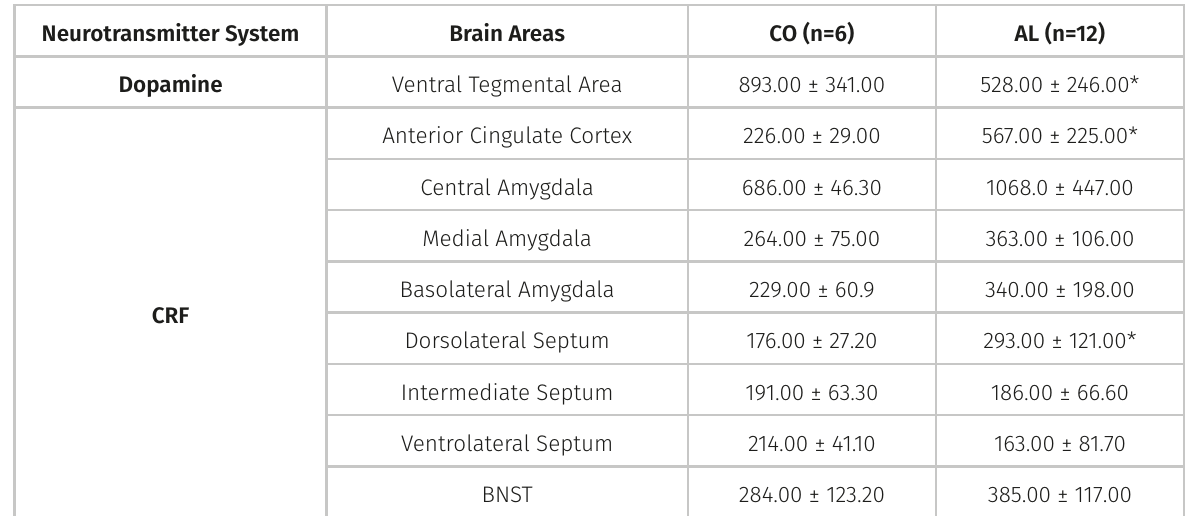
Table II. Number of immunoreactive cells to dopamine and CRF in the analyzed brain areas in Control (CO), and Alcohol (AL)